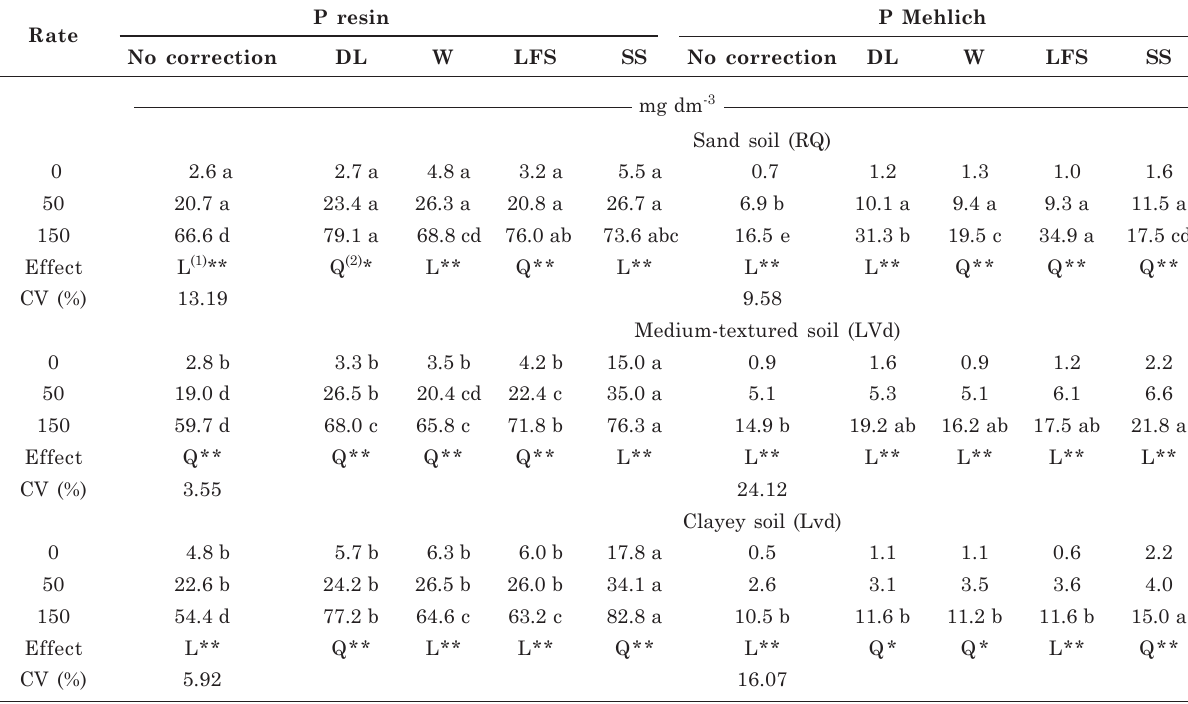
Table 4. Soil P content, extracted by the resin method and by Mehlich-1, after application of correctives (dolomitic lime - DL, ladle furnace slag - LFS, wollastonite - W, steelmaking slag - SS) and P rates P resin P Rate